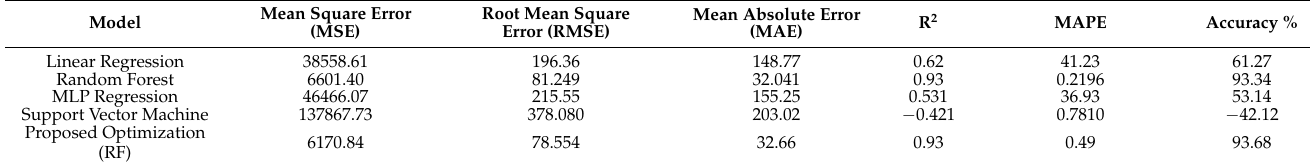
Table 6. Results obtained from Hawaii training dataset for the year